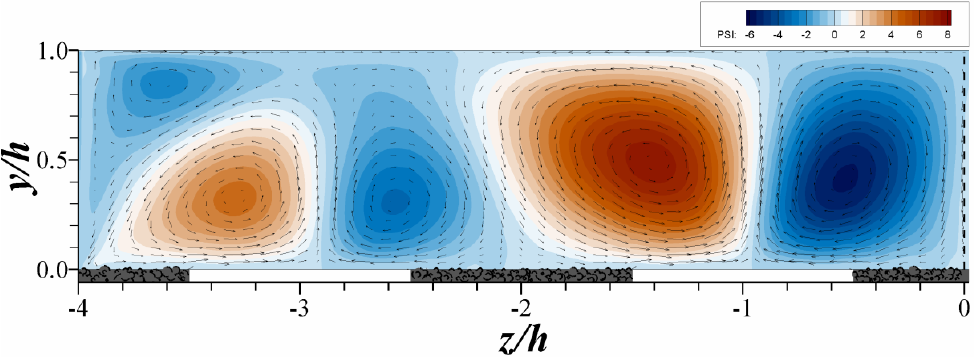
Figure 6. Contours of the streamfunction together with the vectors of the secondary flow in the left half of the